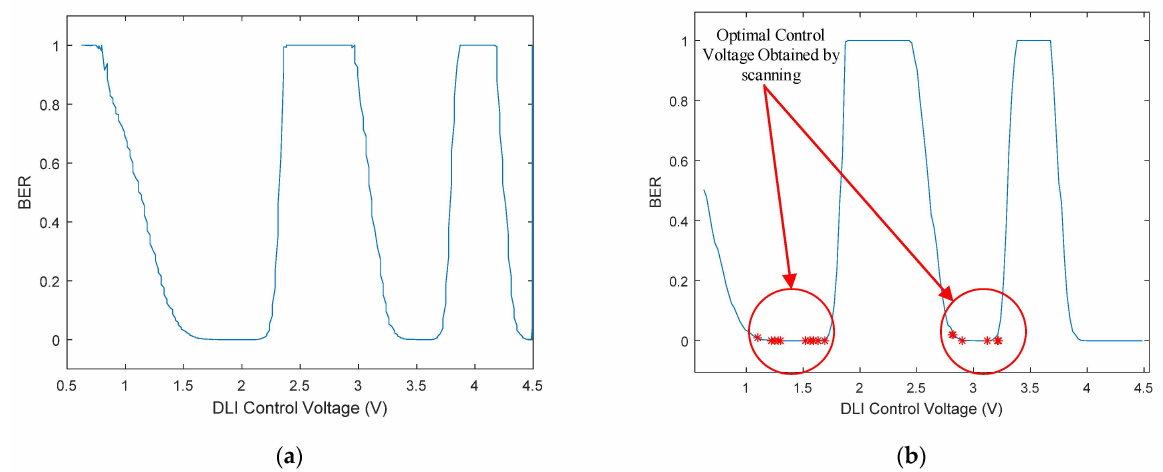
Figure 12. Implementation performance of the scan-based method in FPGA: ( a ) represents the BER curve of the test data; ( b ) marks the optimal control voltage obtained by scanning.